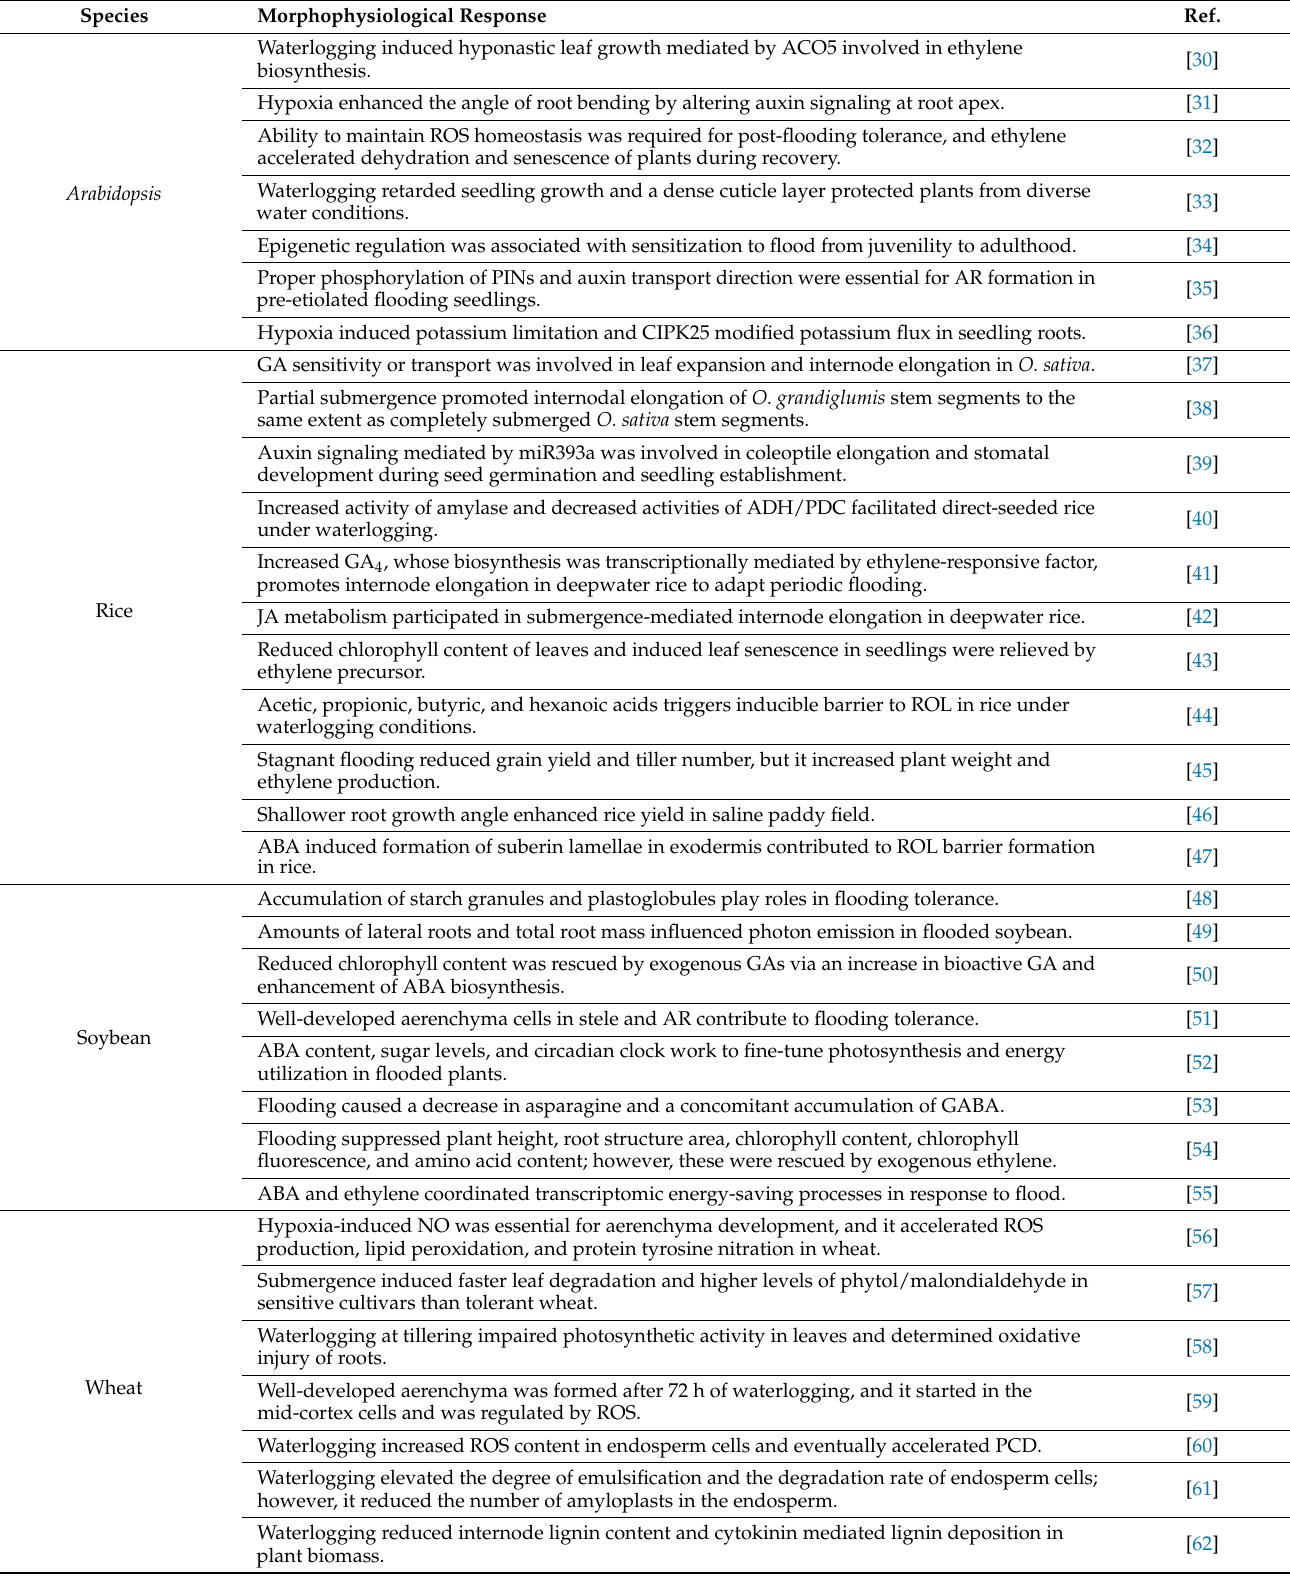
Table 1. Morphophysiological responses of plants to flood